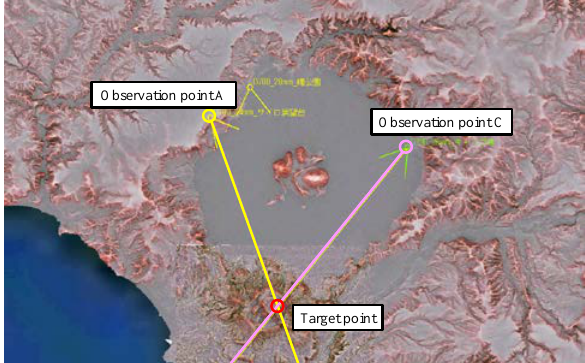
Figure 10. Measurement result (Horizontal position)